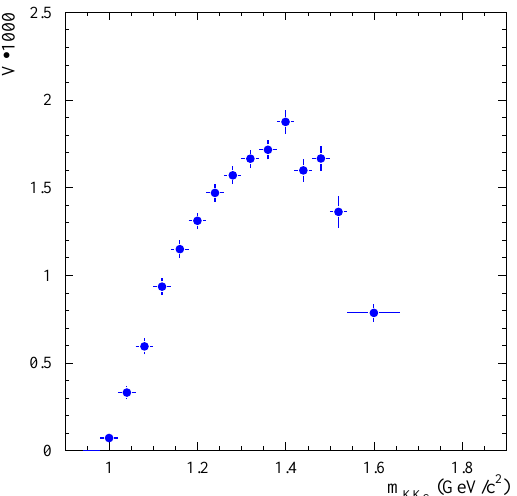
ν τ decay. Only statistical S